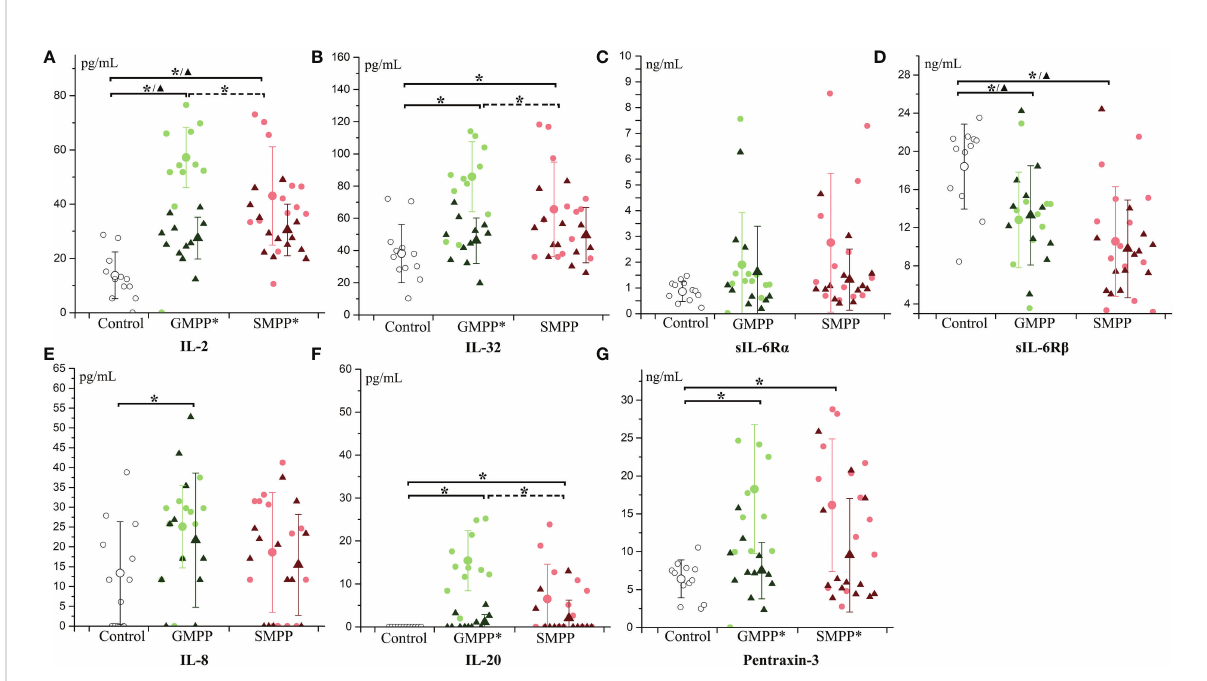
FIGURE 6 The level of multifunctional cytokines: (A) IL-2; (B) IL-32; (C) sIL-6R a ; (D) sIL-6R b ; (E) IL-8; (F) IL-20; (G) Pentraxin-3. Indications of groups and symbols are the same as described in Figure 2.